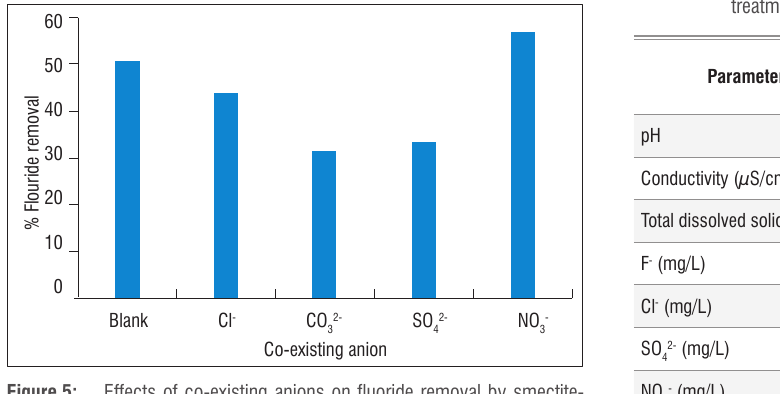
Physicochemical parameters of field water before and